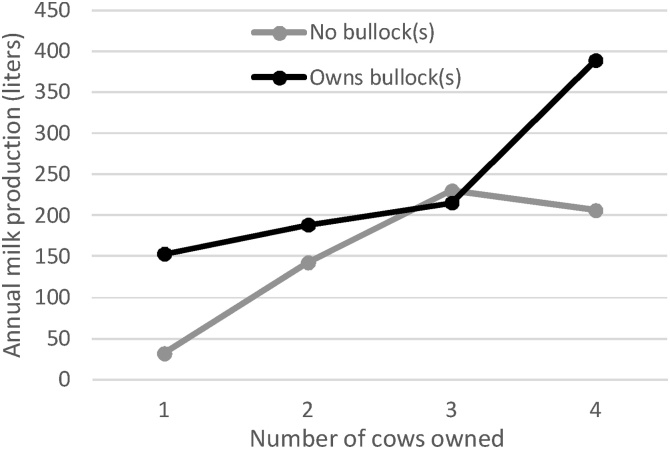
Mean milk production as a function of the number of cows owned, for households own and do not own bullocks.